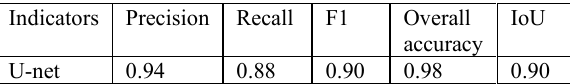
Table 1 . Validation of the U-net algorithm identification